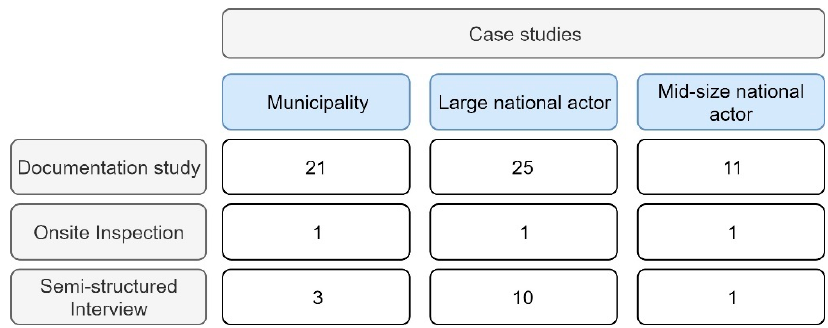
Figure 2. Numbers of case-specific documents examined as part of the case studies.